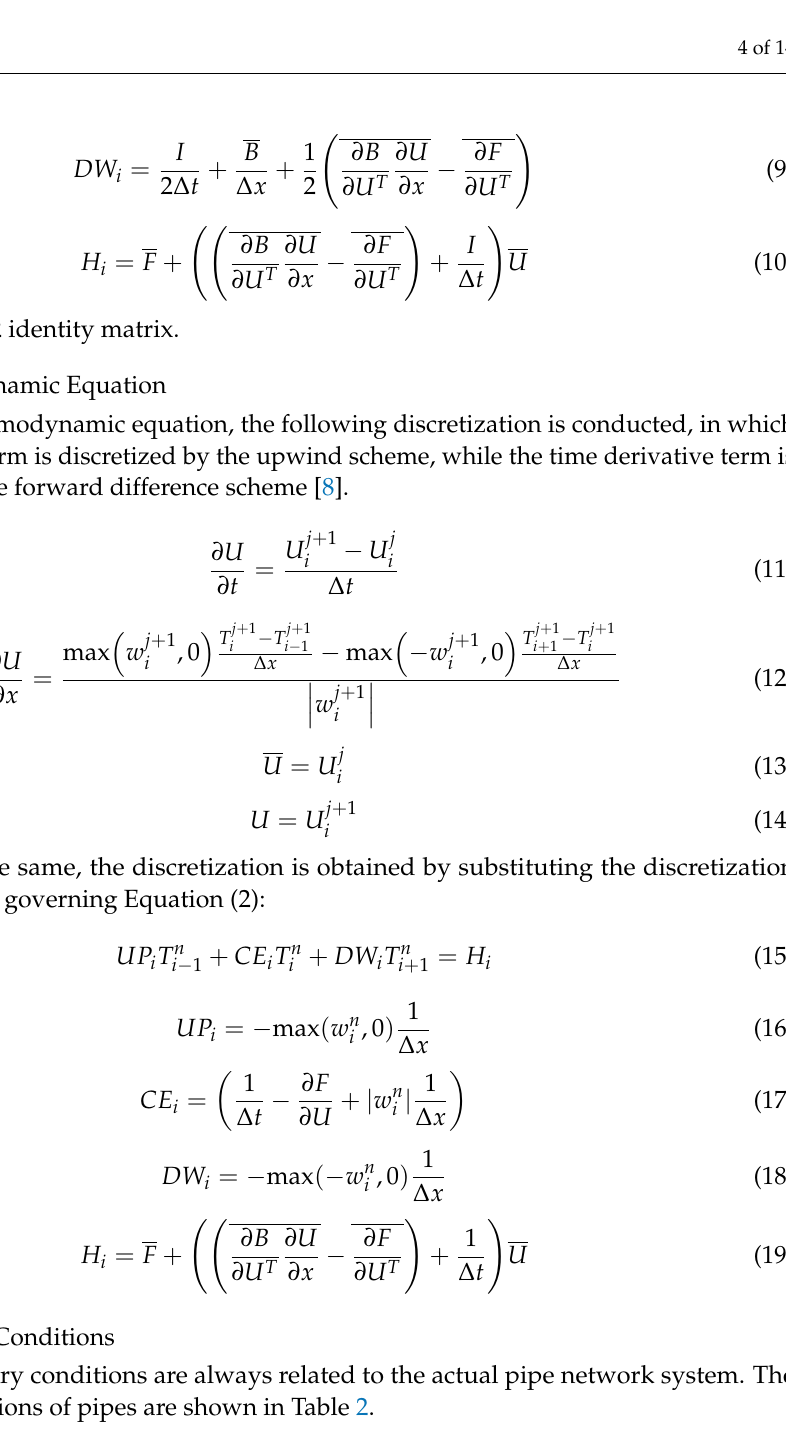
Table 2. Boundary